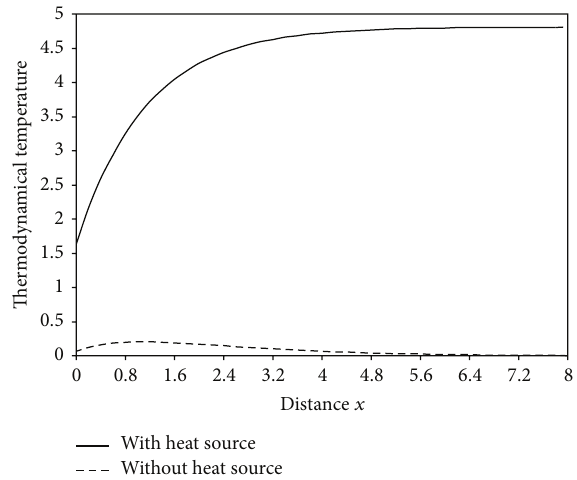
Figure 15: Distribution of thermodynamical temperature with distance 𝑥 .